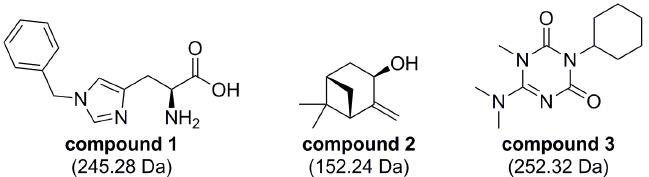
Figure 6. Chemical shift perturbations of FtsQ p with compounds 1, 2 and 3. Each panel shows the superimposed spectra of 200 µM FtsQ p without the fragment (green) and in solution with the fragment at 1 mM (blue), and 4 mM (red). Chemical shift perturbations are marked by black arrows. The areas of the close-ups shown in panels ( A – D ) are designated in Figure 5.